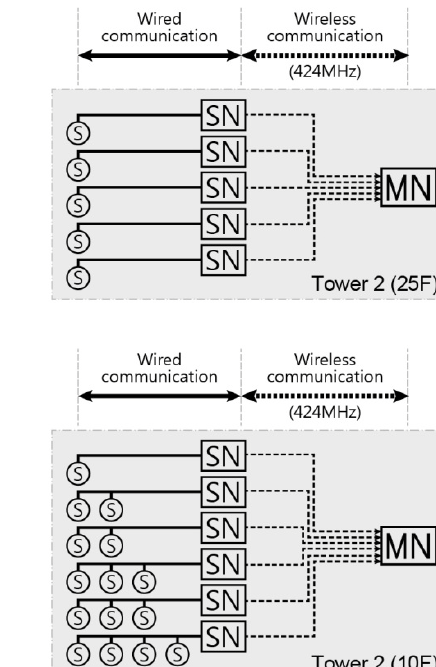
Figure 6. Conceptual diagram of WSNs for tower 1 and tower 2.